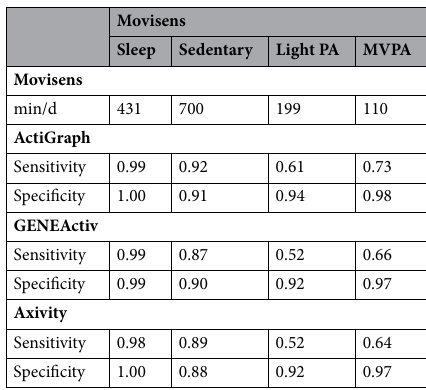
Table 3. Agreement between Movisens-defined and the other monitors (i.e., ActiGraph, GENEActiv and Axivity) in the definition of sleep, sedentary time, light PA, and MVPA. MVPA moderate-to-vigorous physical activity, PA physical activity.